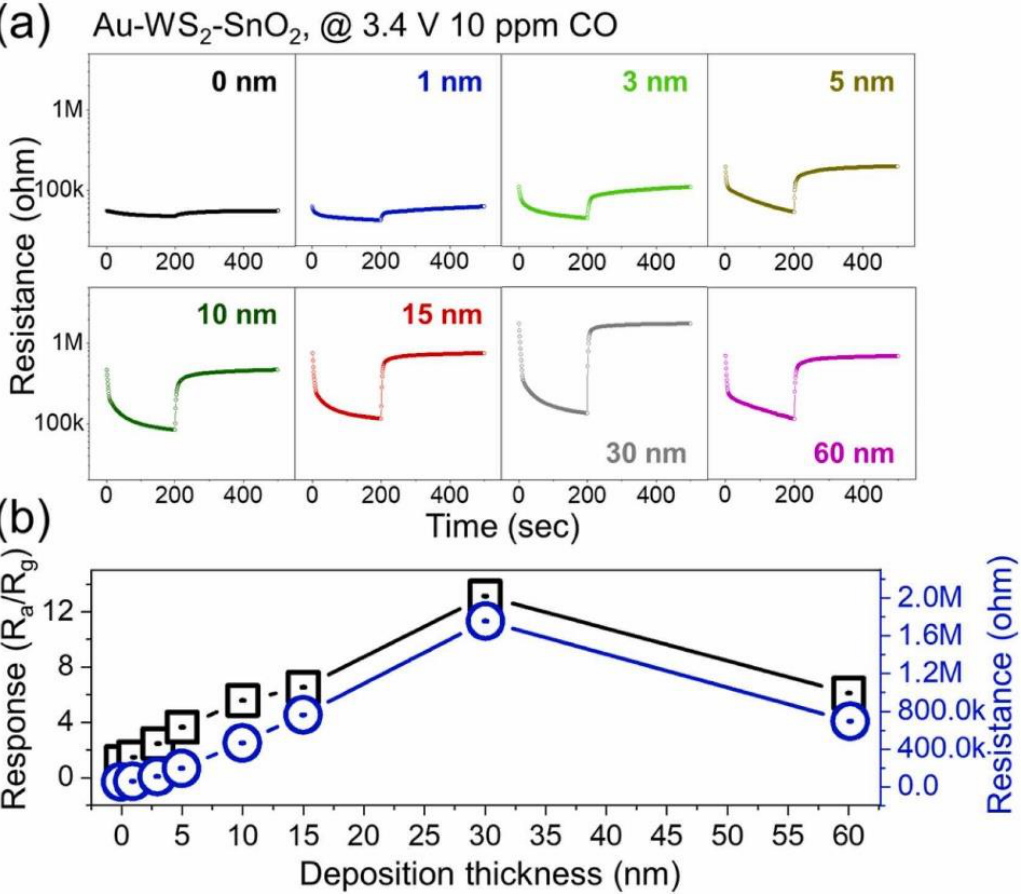
Figure 10. ( a ) Dynamic resistance plots of Au-decorated WS 2 – SnO 2 C – S NS gas sensors with different shell thicknesses to 10 ppm of CO gas at 3.4 V. ( b ) Corresponding response and base resistance versus the shell thickness. Reprinted with permission from Ref. [112]. Copyright 2022, Elsevier.